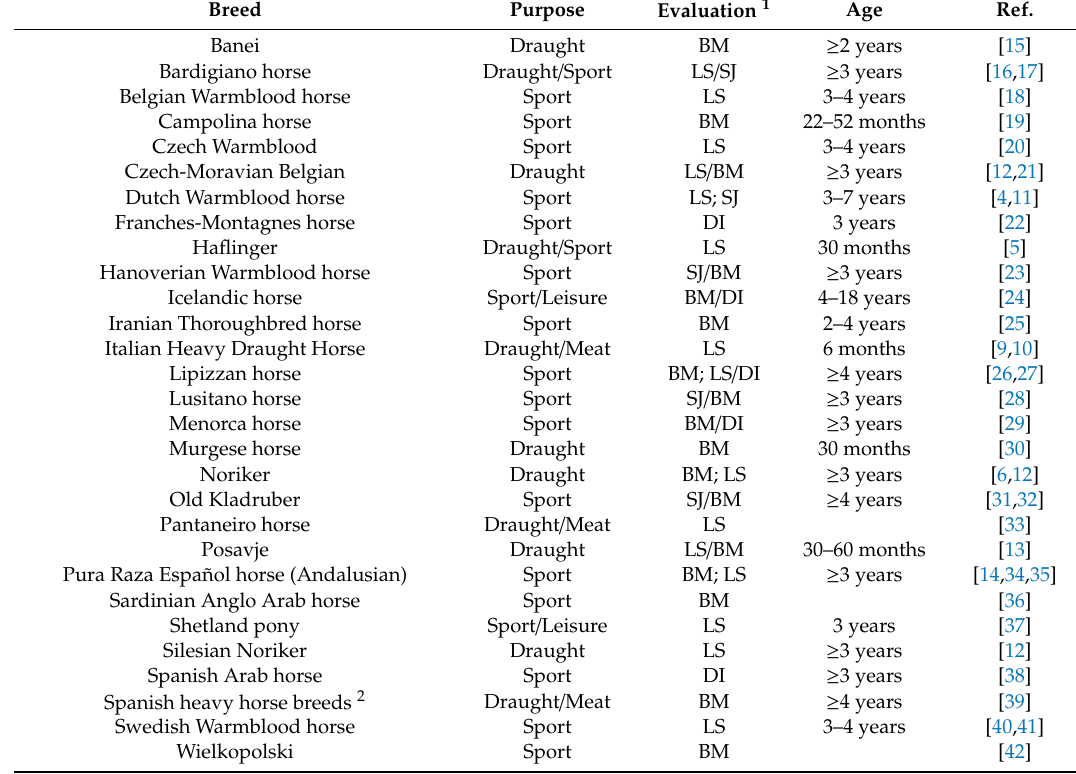
Table 1. Overview of morphologic evaluation in some horse breeds.